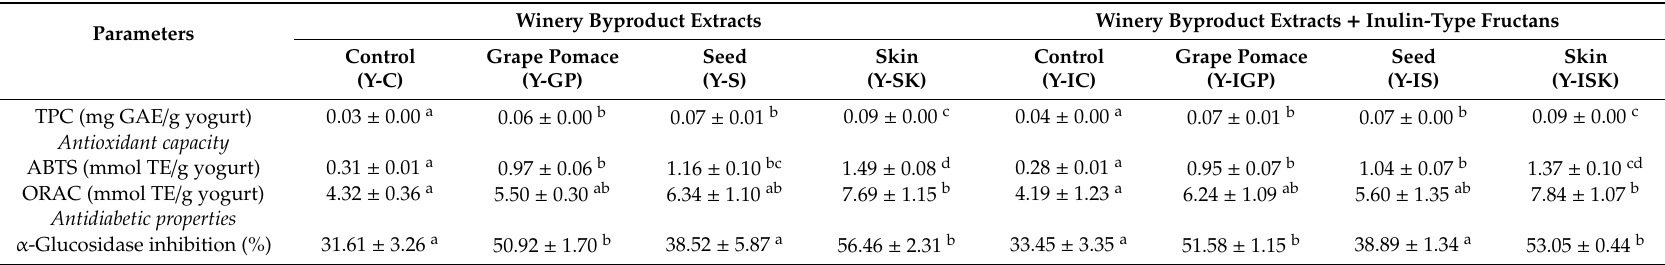
Table 2. TPC, antioxidant capacity and antidiabetic properties of yogurts containing winery byproduct extracts with or without inulin-type